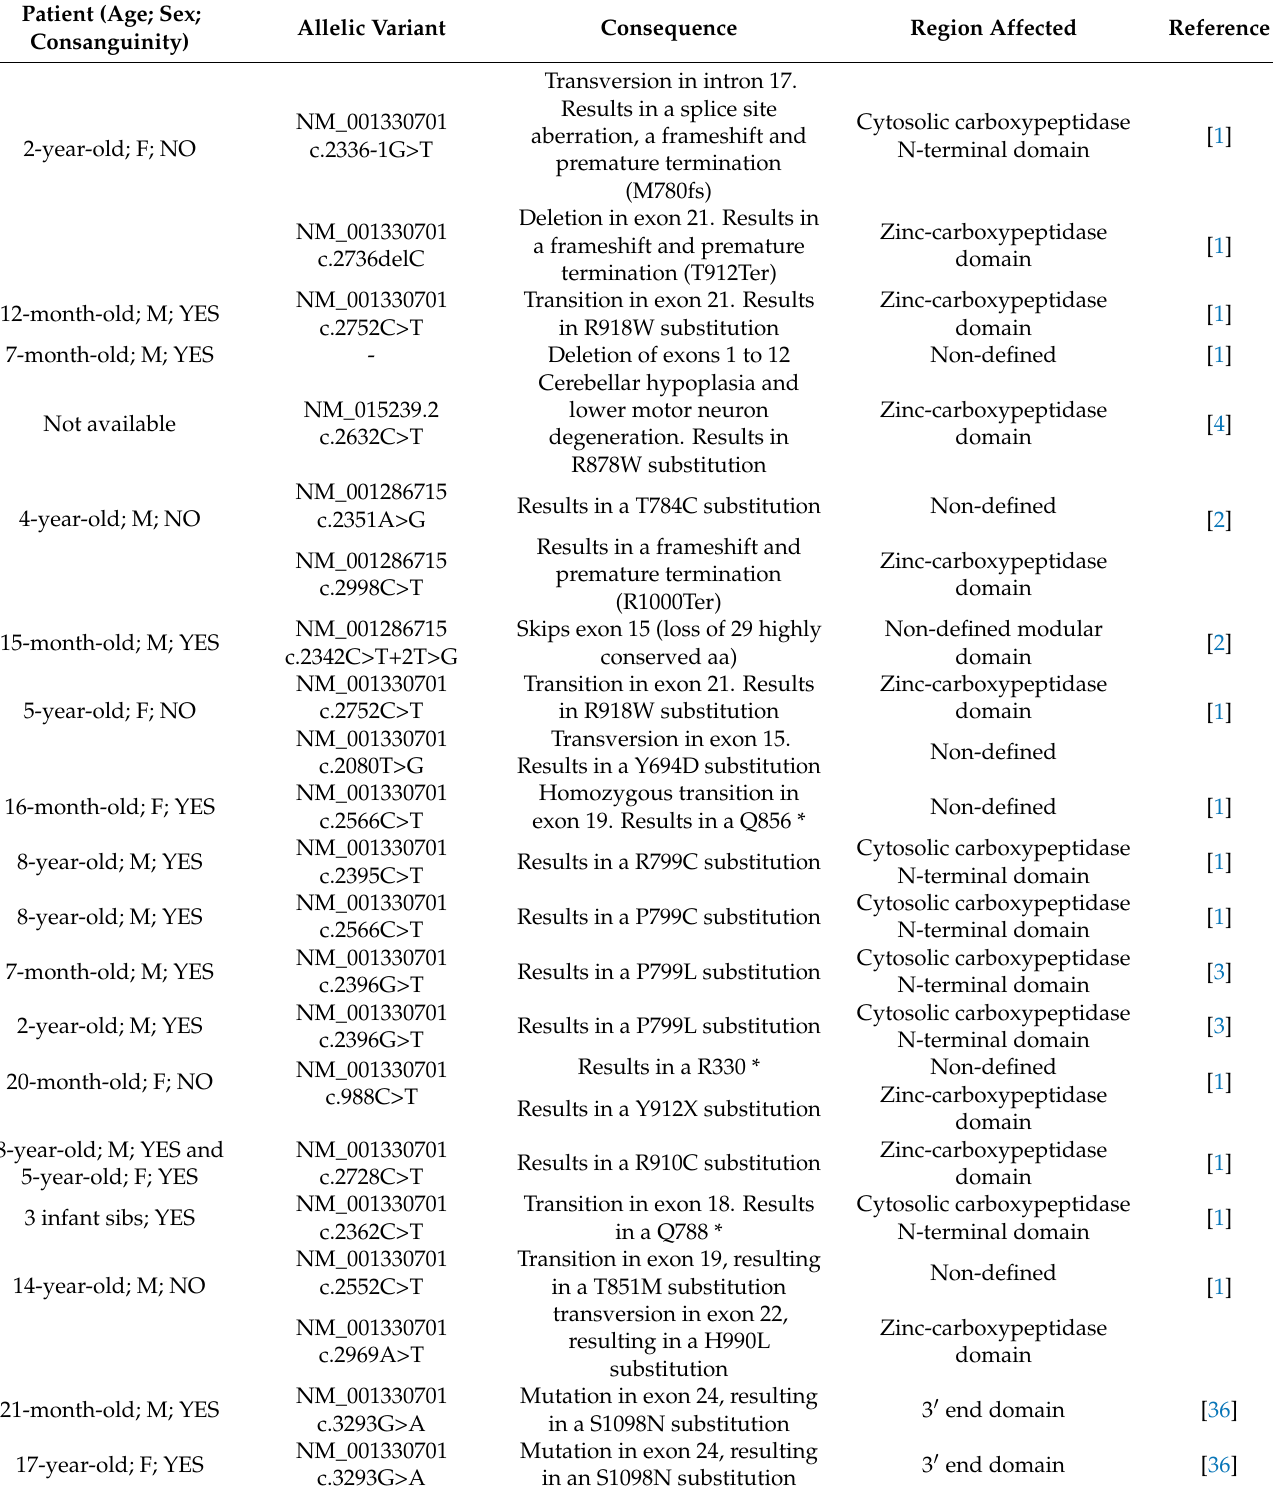
Table 1. Identified biallelic variants in the AGTPBP1 gene. M: Male F: Female. * means substitution. Patient (Age;